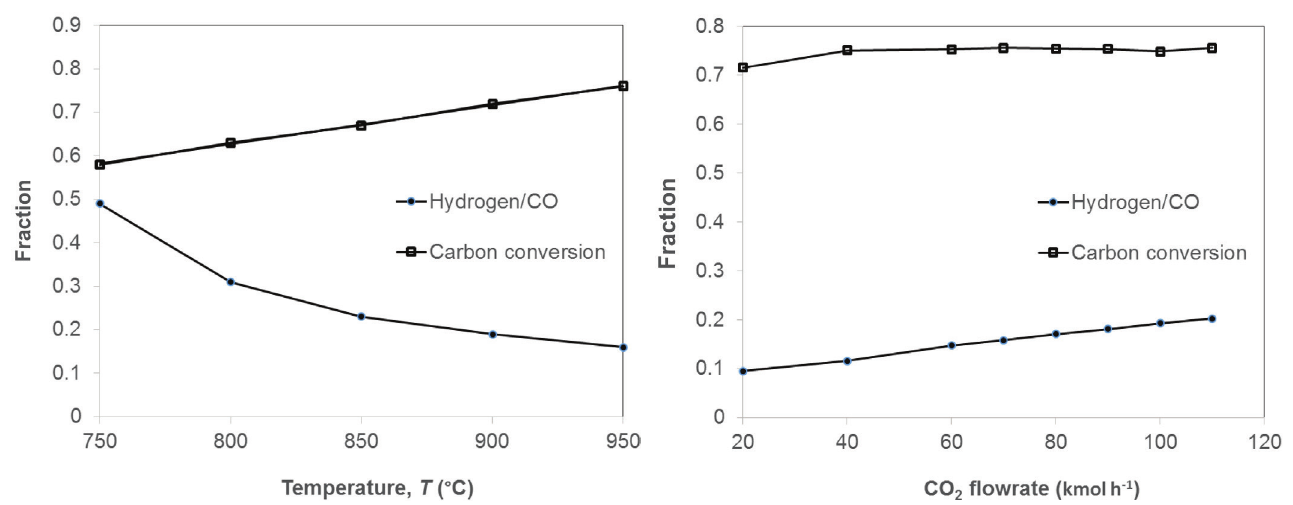
Fig. 2 – Effect of gasification reactor temperature on syngas quality and carbon conversion